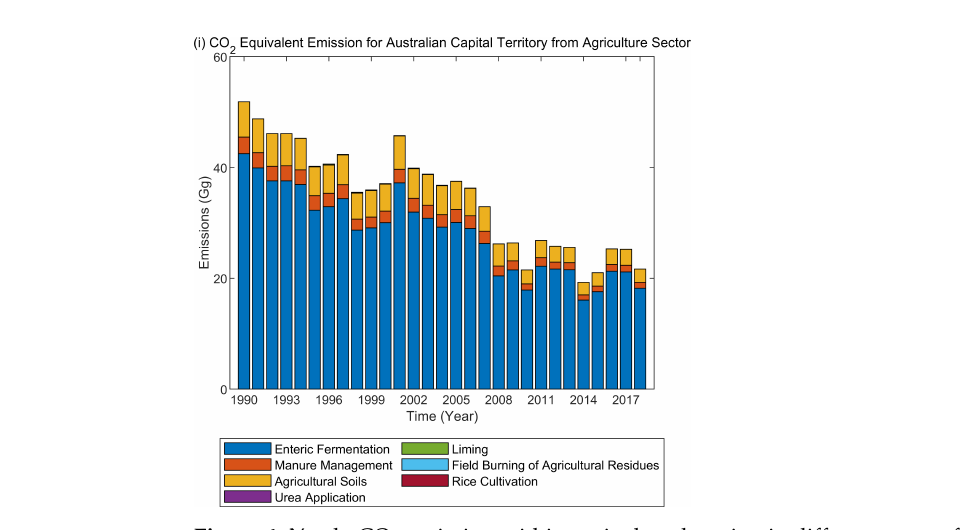
Figure 4. Yearly CO 2 emission within agricultural section in different parts of